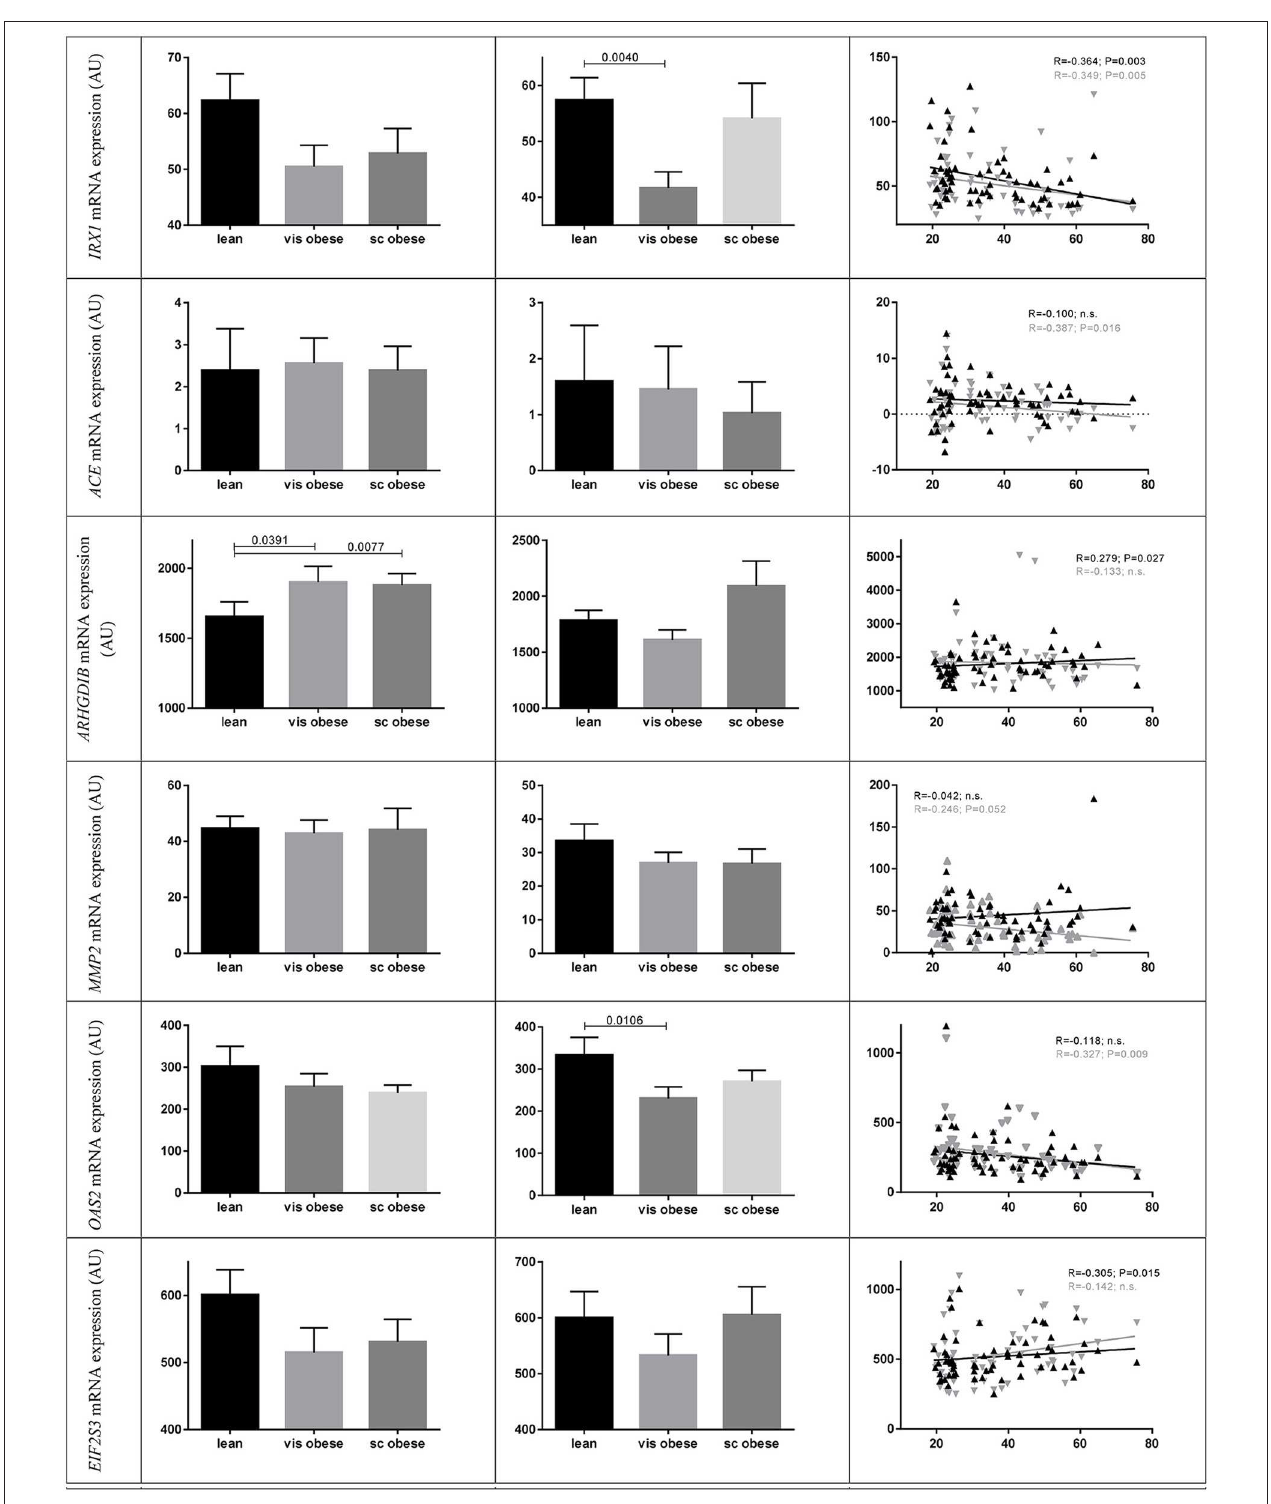
FIGURE 5 | Human mRNA expression between BMI groups and correlation with BMI. Data present means ± standard error of the mean (SEM). For the lean BMI group 23 subjects were included, for visceral (vis) obese 17 and for subcutaneous (sc) obese 21. For correlation analysis black triangles and lines present subcutaneous and gray triangles and lines visceral mRNA gene expression ( N = 63 paired samples). P -values were calculated using Mann-Whitney-test and Spearman’s Rho correlations. For ACE the transcript variant 1 of NM_000789.2 and for OAS2 the transcript variant 2 of NM_002535.2 is shown.